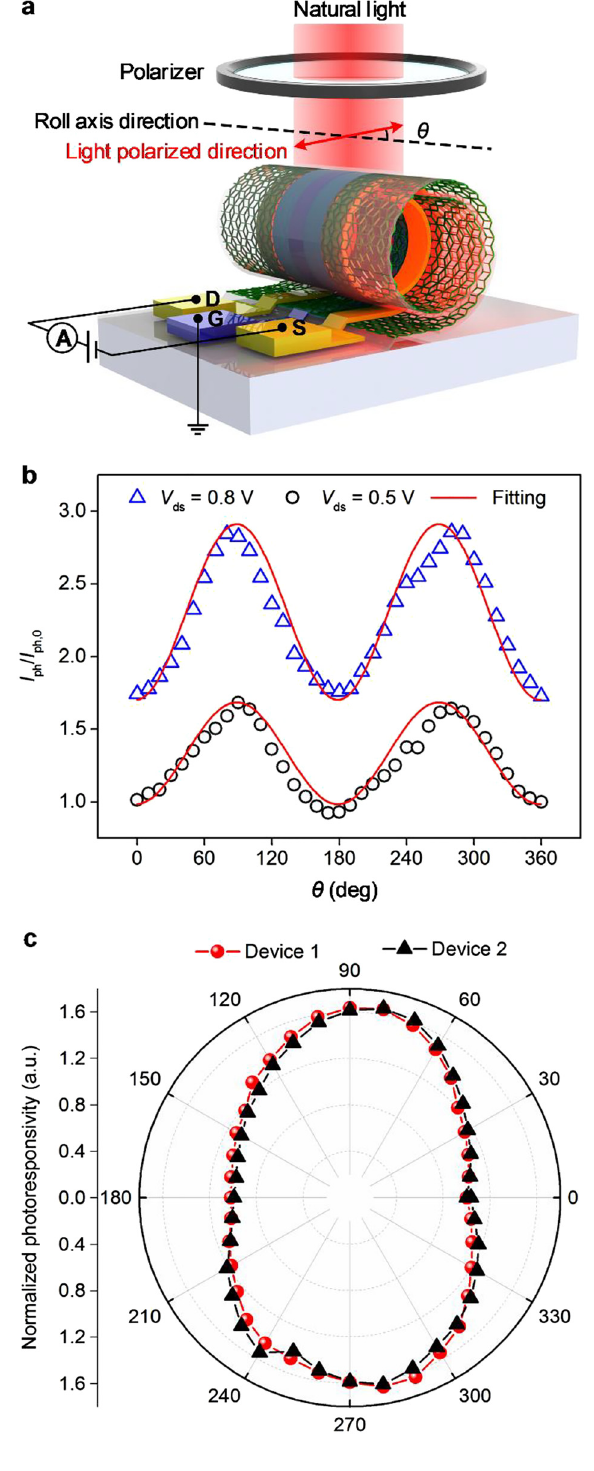
under different source – drain bias voltages, where I ph,0 represents the photocurrent measured at the polarization angle of 0 ° . (c) The coordinates. 3D, three-dimensional; FET, fi eld-effect transistor; MoS 2 , molybdenum disul fi